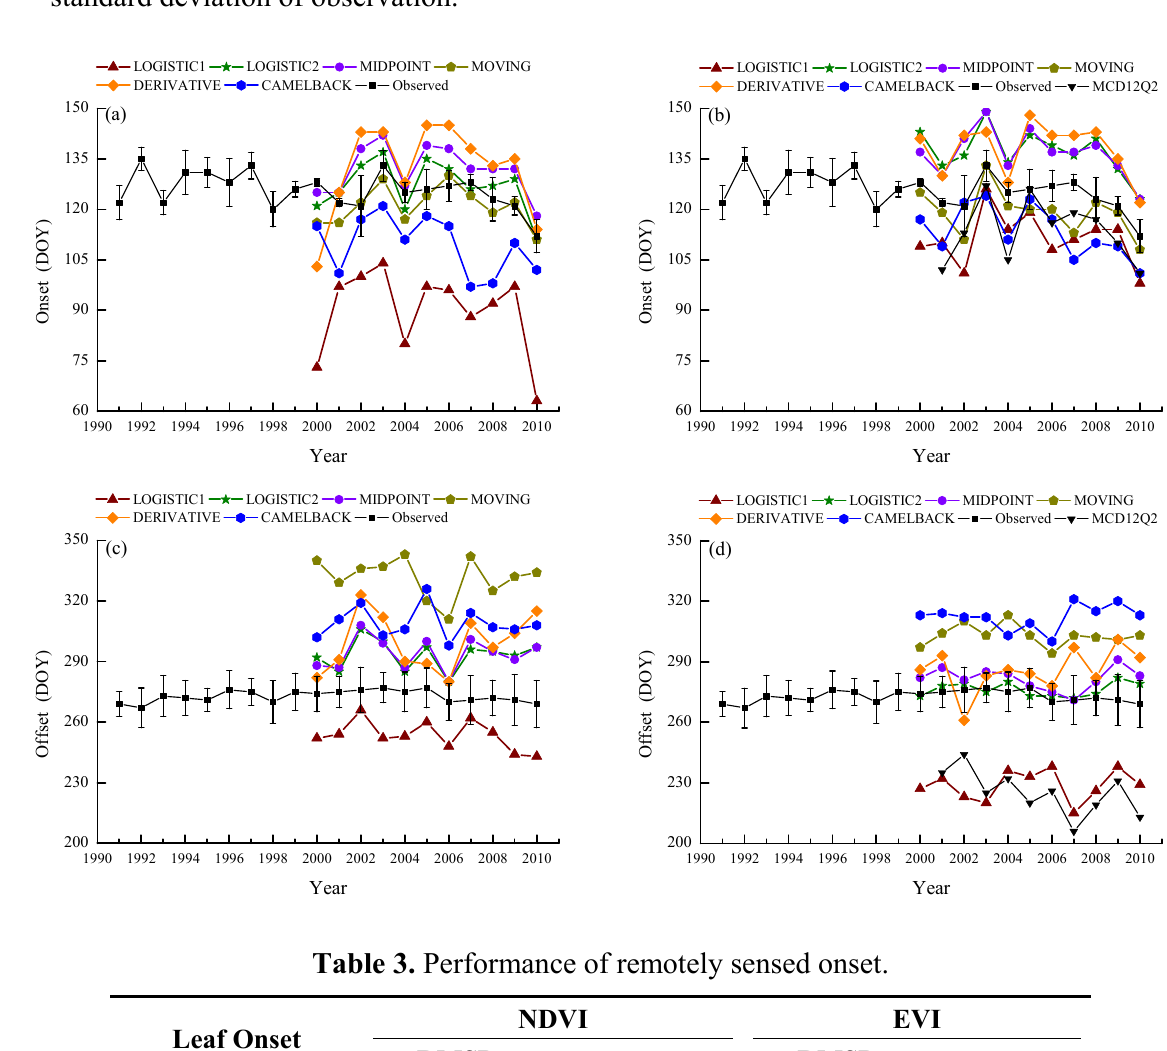
Figure 3. Ground observed phenology with remotely sensed onset from NDVI ( a ); onset from EVI ( b ); offset from NDVI ( c ); and offset from EVI ( d ). Error bars indicate the standard deviation of observation.